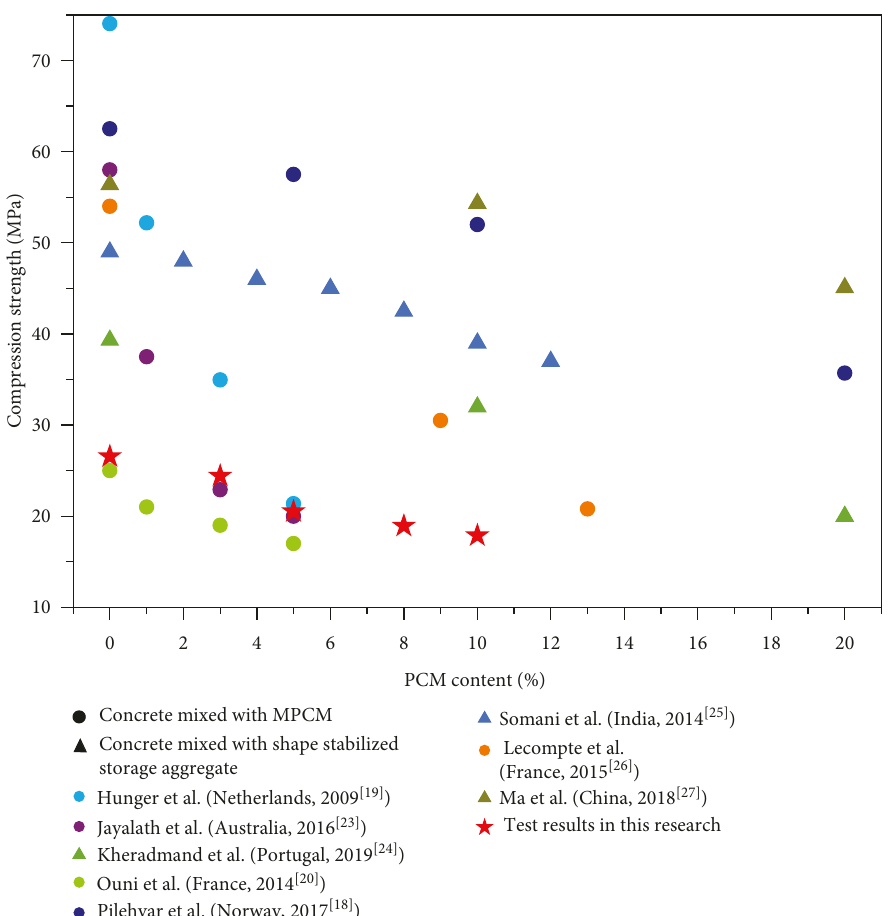
Figure 14: The relation curve between compressive strength and PCM content by different